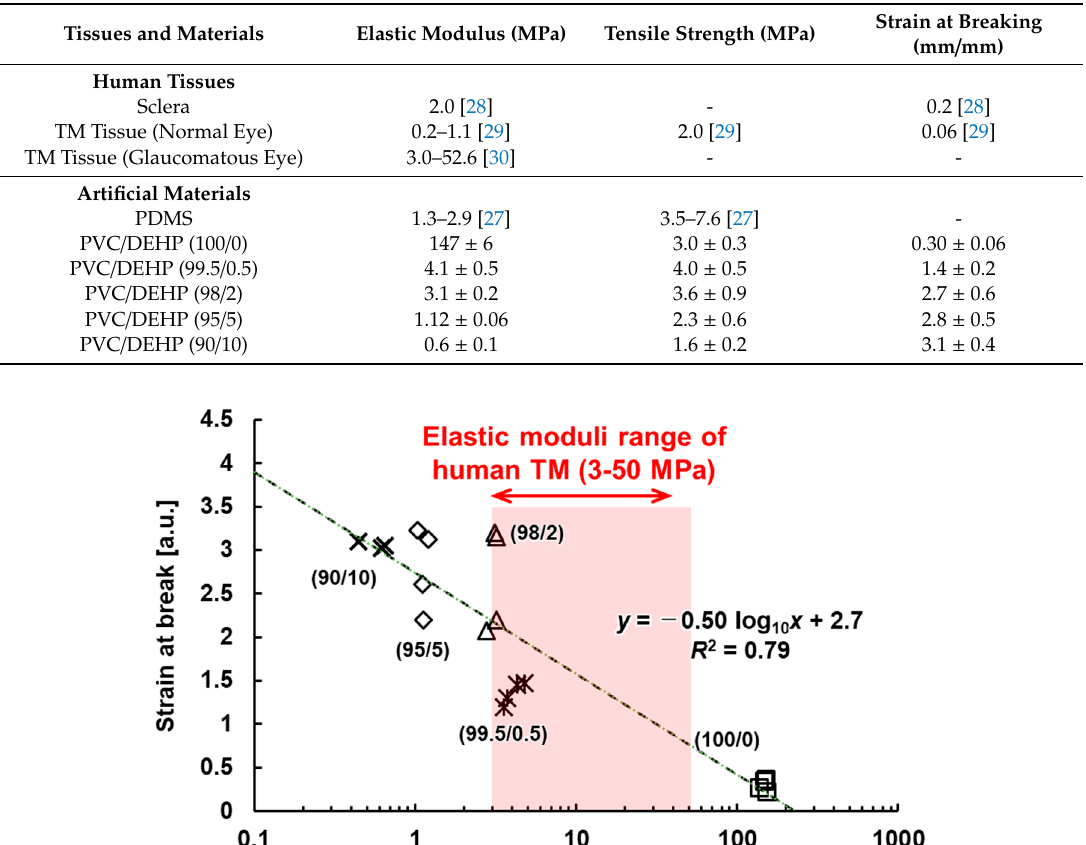
Figure 7. Stress–strain behavior of trabecular meshwork model. Numbers indicate the weight ratio of the PVC/DEHP mixture. Mechanical properties of Polydimethylsiloxane (PDMS) and Polyvinyl chloride (PVC) / Di-(2-ethylhexyl) phthalate (DEHP) used in this study to replicate sclera and trabecular meshwork tissues, respectively.